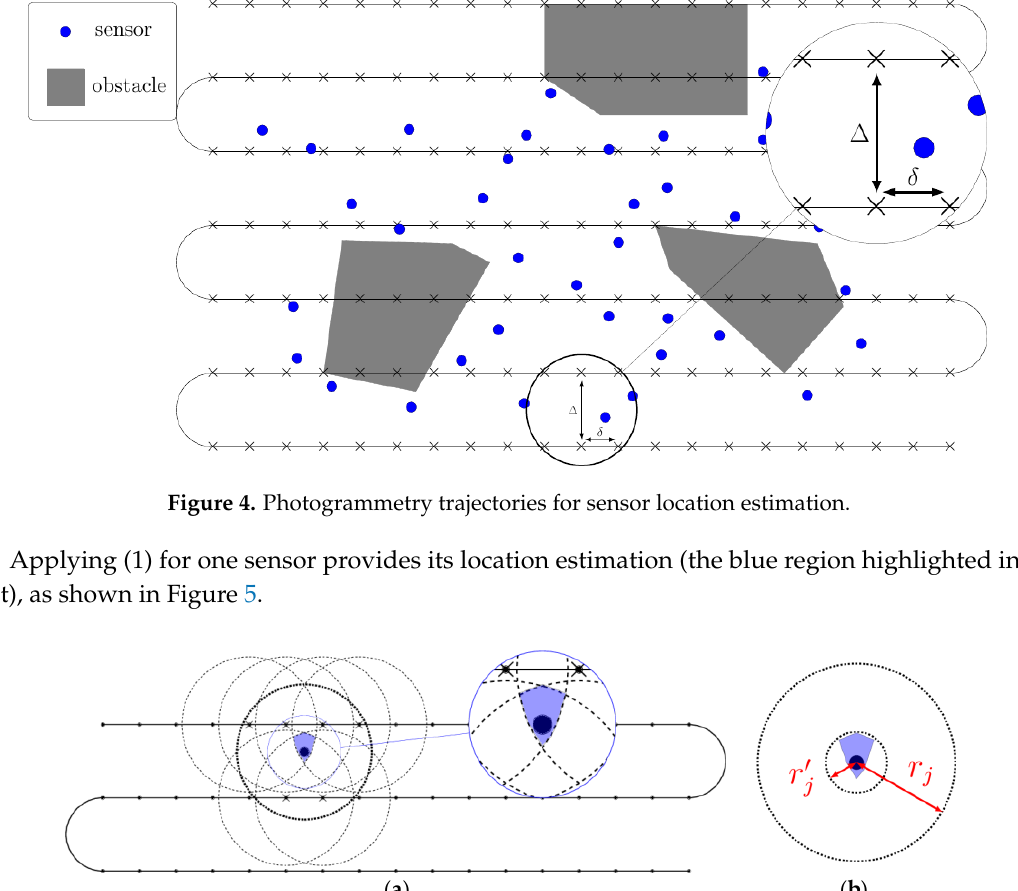
Figure 3. Example of aerial vehicle flight path planning in a multi-obstacles environment.